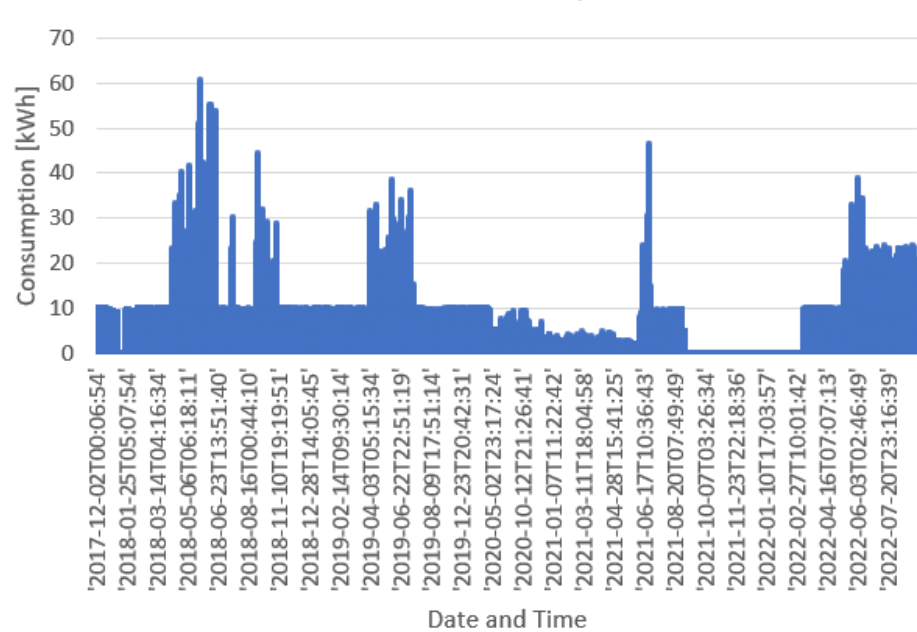
Figure 5. Electricity consumption without outliers at the swimming complex.